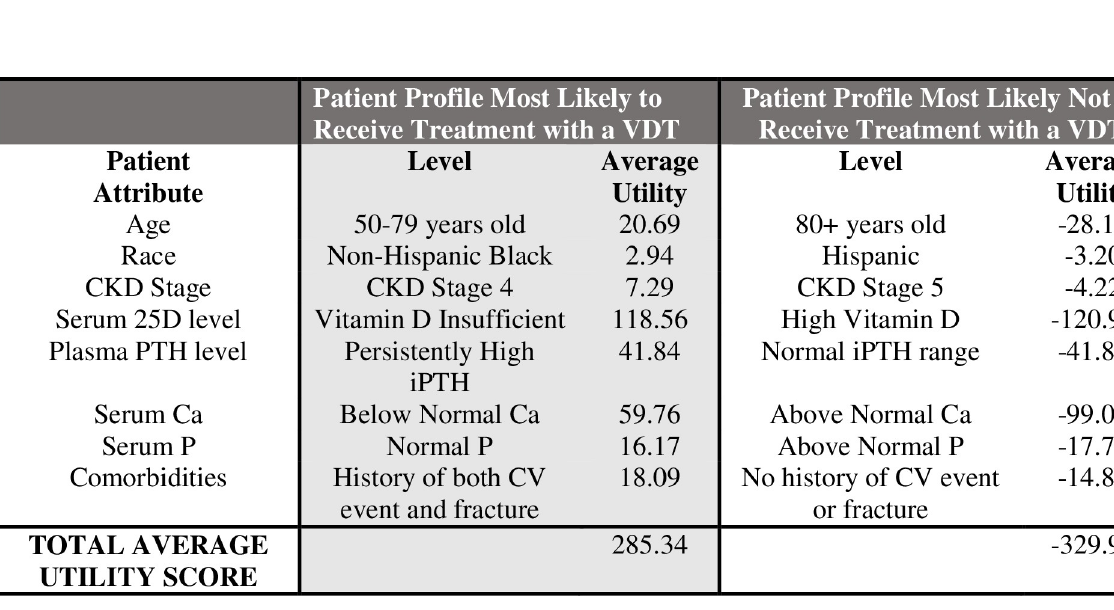
PLOS ONE | https://doi.org/10.1371/journal.pone.0283531 March 29,